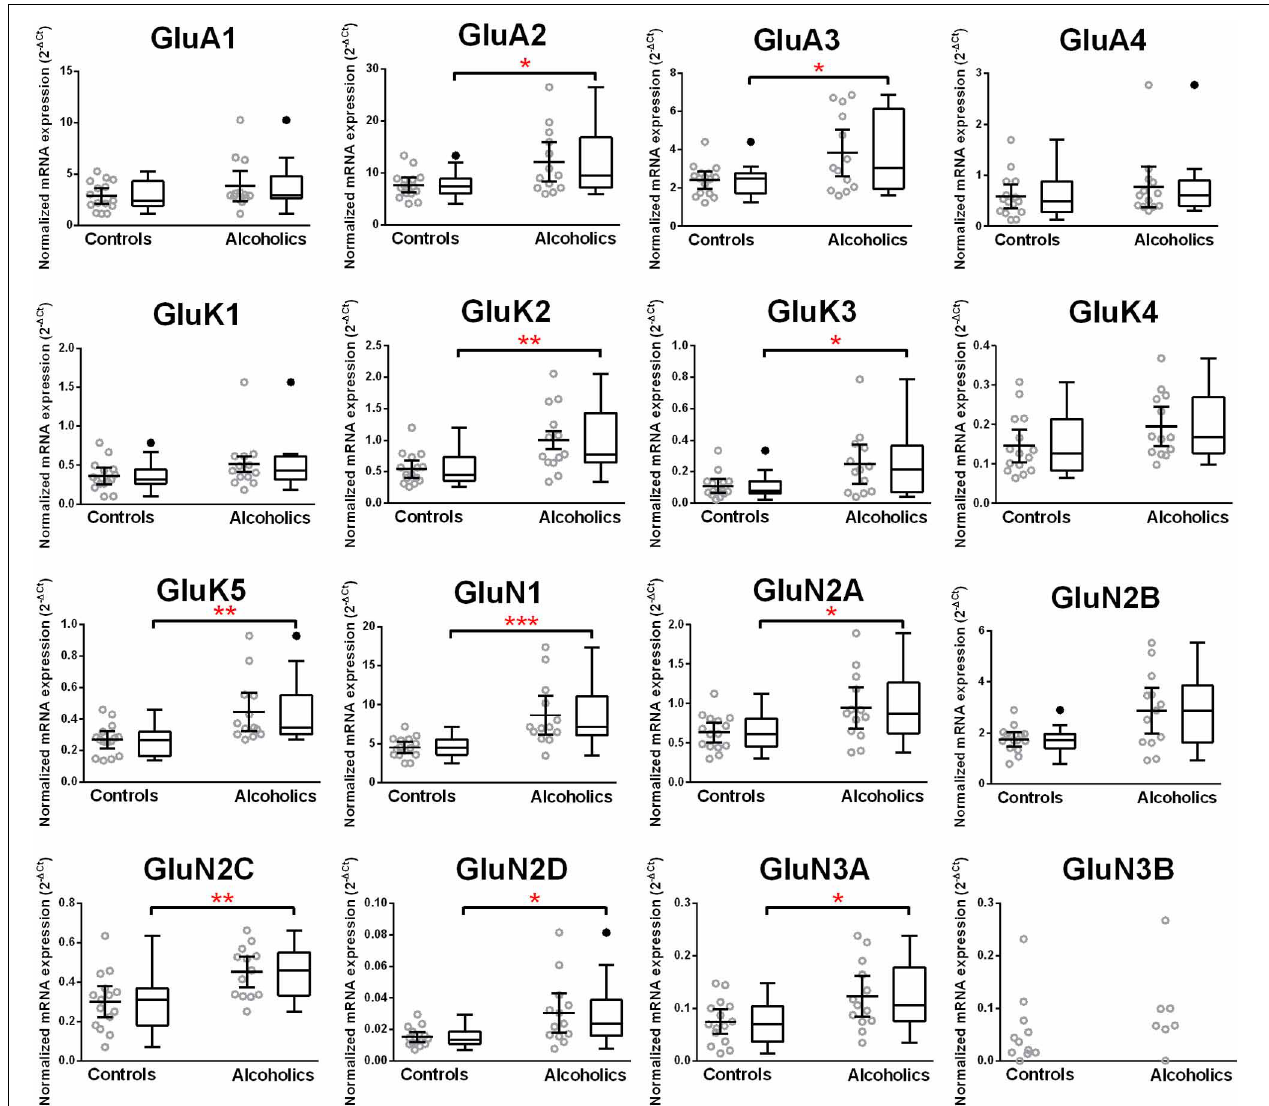
FIGURE 2 | Expression of ionotropic glutamate receptor subunits mRNA in the hippocampal dentate gyrus of controls ( n = 15) and alcoholics ( n = 13). Data from each group were presented as scatter dot plot ( ◦ ) with mean and 95% confidence interval and box and whiskers plot with median and whiskers plotted by Tukey method to determine outliers ( • -above or below the whiskers). Statistical analysis was performed after excluding outliers. One Way ANOVA with Bonferroni post-hoc test, GluK1, df = 24, p = 0 . 11; GluN2C, df = 24, p = 0 . 0084;